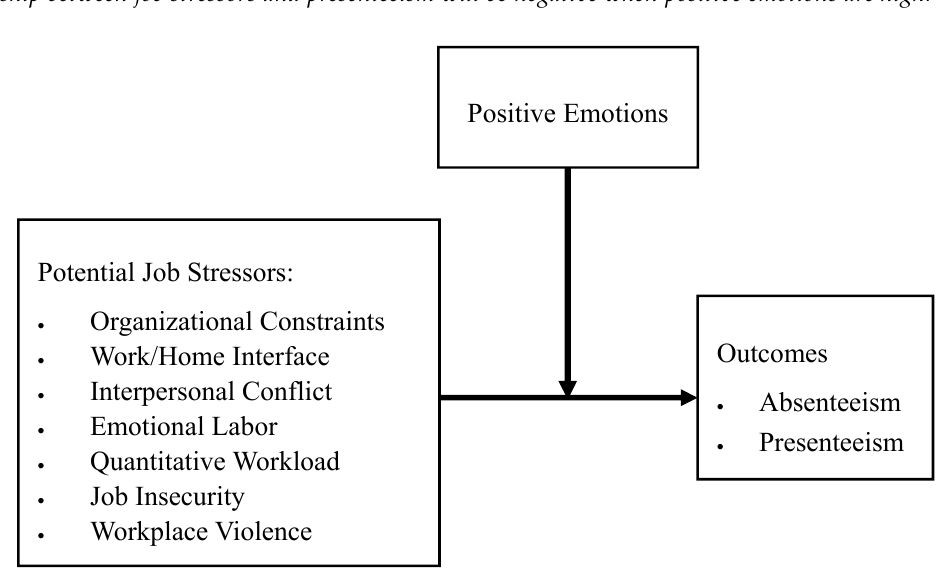
Figure 1. Stressor–outcome model.